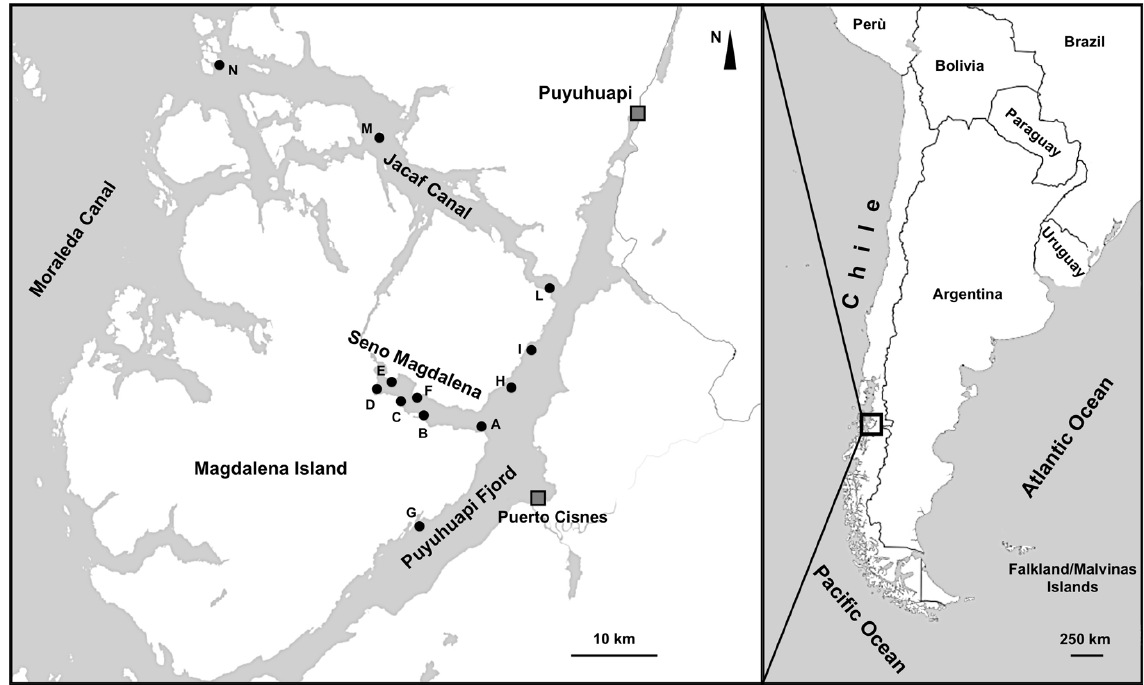
Fig. 1. Study area with twelve sampling sites (A–I,